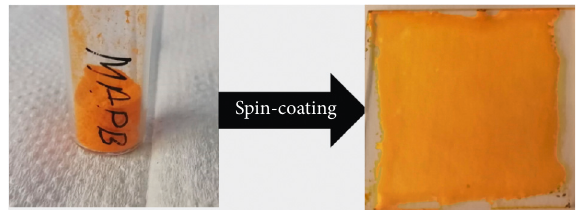
Figure 1: Powder and thin film of MAPB perovskite.